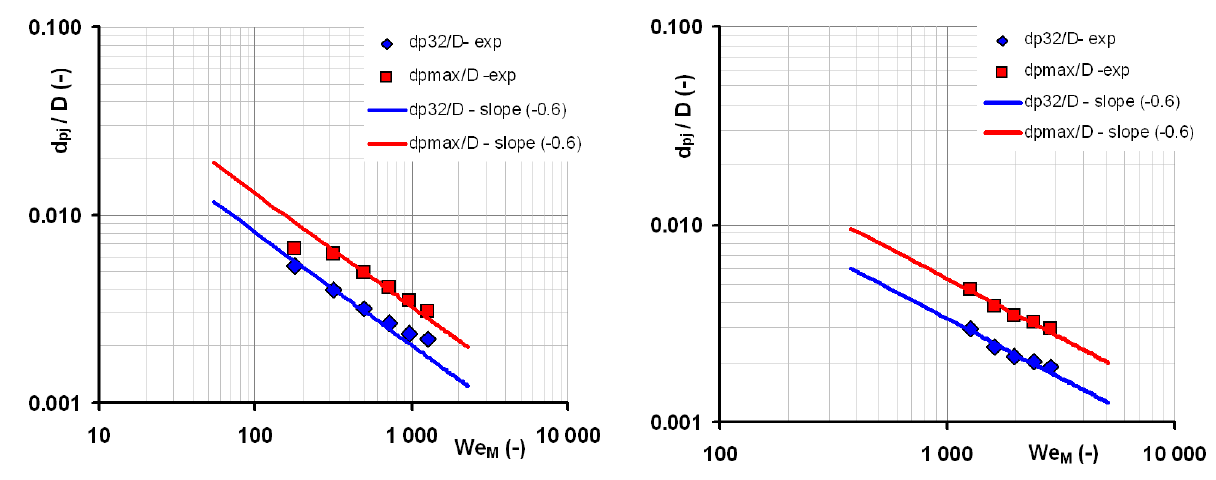
Fig. 9. Dimensionless correlations for ratios d p32 /D and d pmax /D – high-shear tooth